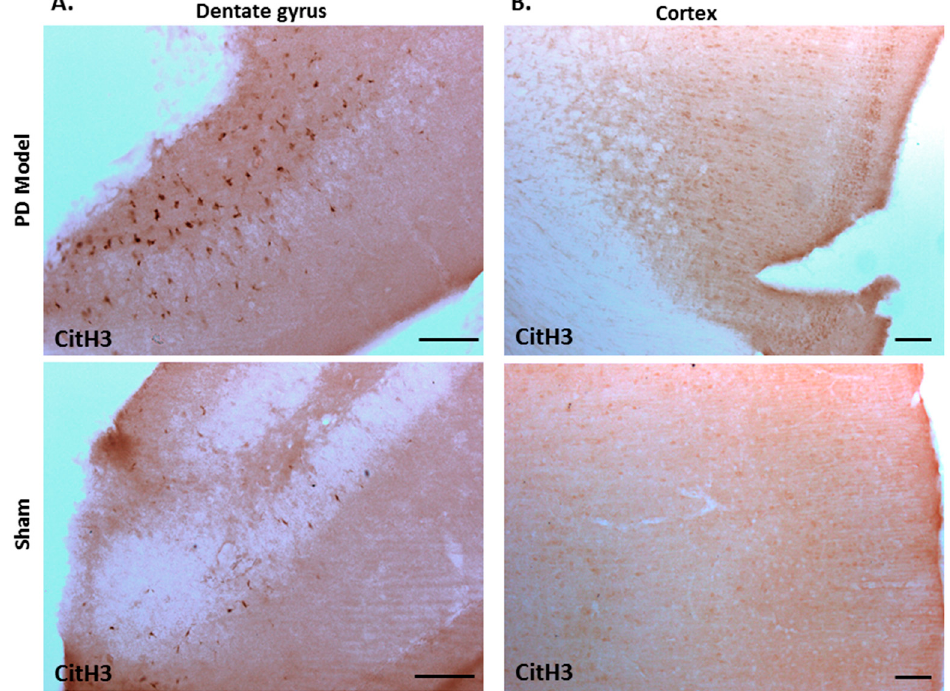
Figure 9. Deiminated histone H3 staining is increased in the cortex and dentate gyrus of pre-motor PD models. Immunohistochemical staining showed increased protein detection of deiminated histone H3 (citH3) in: ( A )) the dentate gyrus; ( B ) the cortex of the pre-motor PD models, compared with those in the control sham animals. The scale bars indicate 100 µ m in all